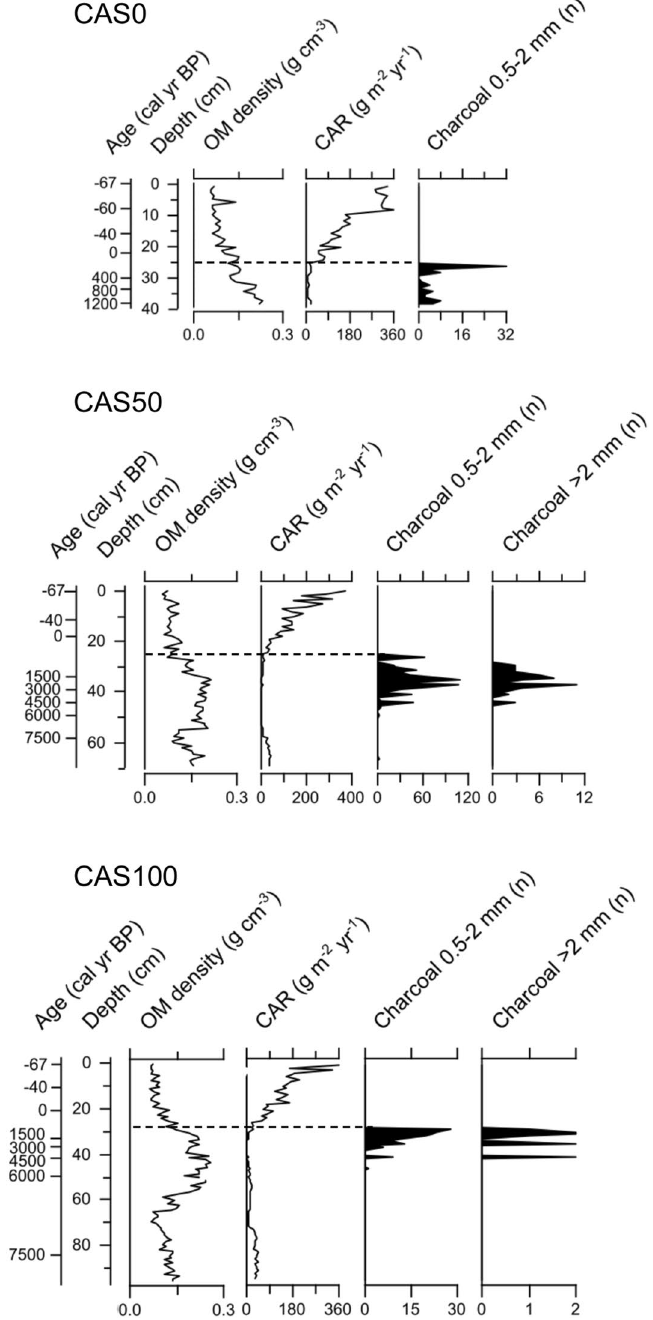
Figure 3. Peat organic matter (OM) density, carbon accumulation rates (CAR) and charcoal records 26 from the three studied peat cores along the transect. Dashed lines indicate the last fire event above which recent apparent rates of C accumulation (RERCA) were calculated. The detailed plant macrofossil data for these cores are presented in 26